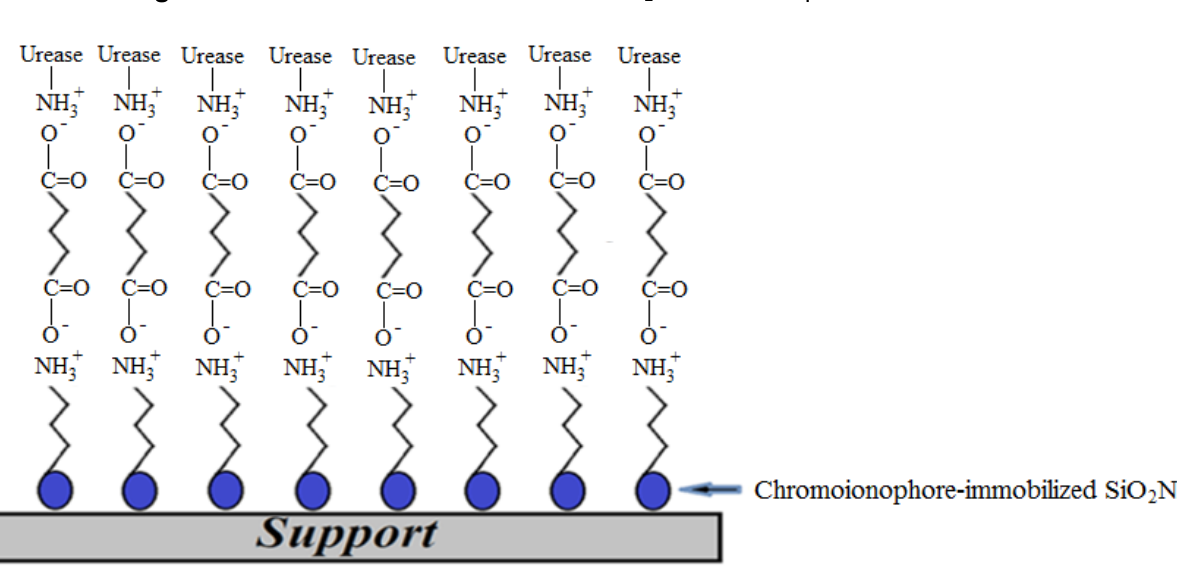
Figure 1. Schematic illustration of the SiO